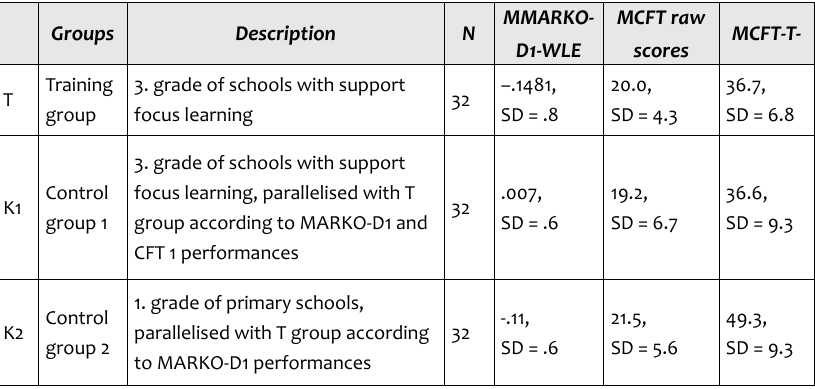
Table 1: Descriptive specification of the